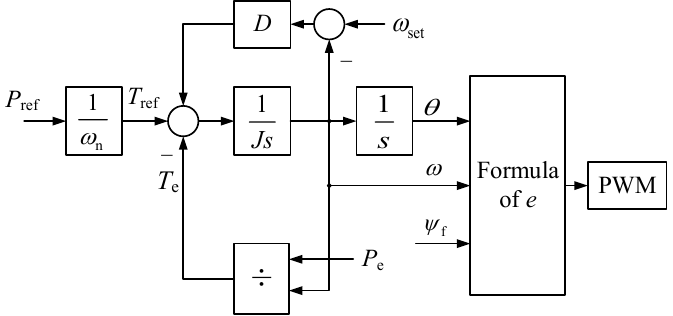
Figure 2. Rotor mathematical model of